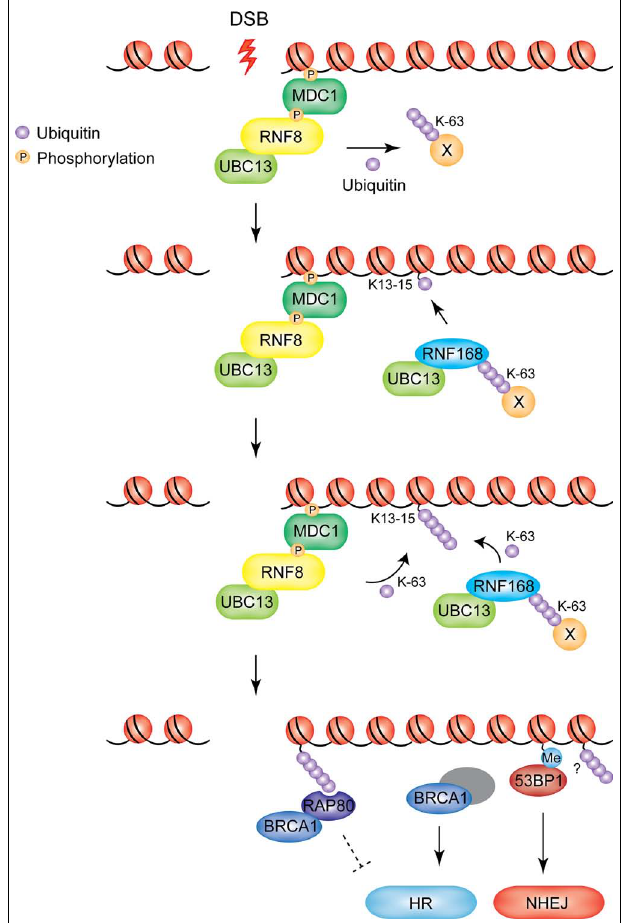
FIGURE 1 | Model of RNF8/RNF168-mediated ubiquitylation at DSBs. RNF8 is recruited to DSBs through its interaction with MDC1. Chromatin-bound RNF8 cooperates with the E2 UBC13 to ubiquitylate an unknown non-nucleosomal target in the vicinity of the damaged chromatin (X). Ubiquitylated target-X is recognized by RNF168, which catalyzes monoubiquitylation of K13-15 on H2A-type histones. RNF8 and RNF168 work in concert to extend the ubiquitin chains on H2A-type histones. BRCA1 and 53BP1 are recruited as downstream effectors. BRCA1 accumulates at DSBs in an RNF8/RNF168-dependent manner, through RAP80, which binds to the K63-linked ubiquitin chains deposited by RNF8/RNF168.The RAP80–BRCA1 complex is thought to inhibit excessive HR, while BRCA1 in complex with several other DNA damage response proteins is known to primarily promote DNA repair by HR. 53BP1 accumulation at DSBs depends on RNF8/RNF168-mediated modifications to the chromatin surrounding the DNA lesion. 53BP1 promotes DNA repair by NHEJ (Me, methylation of